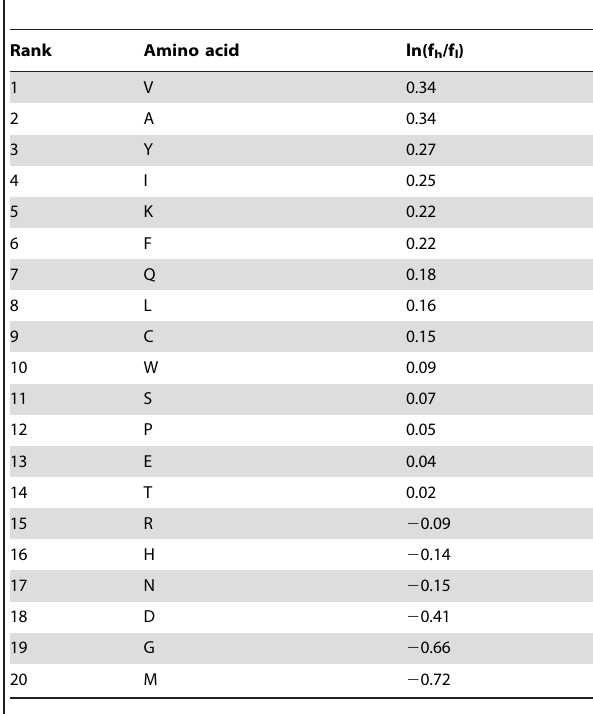
Table 3. Normalized amino acid propensities of the hinge residues with reference to amino acids at the loop